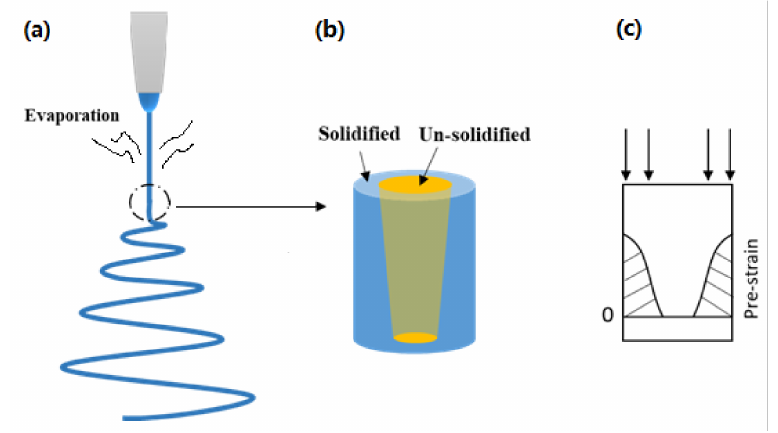
Figure 3. Illustration of electrospinning ( a ), gradual solidifying ( b ), and resulted pre-strain field ( c ). Refer to Figure 4a for an illustration of the cross-section of the dried fiber (with a radius of R ) and the pre-strain in it. The process of wetting by ethanol should start from the surface of the dry fiber. For simplification, we may assume that r is the radius of the inner core (layer II, without any pre-strain) and the outer shell (layer I) is uniformly pre-strained.